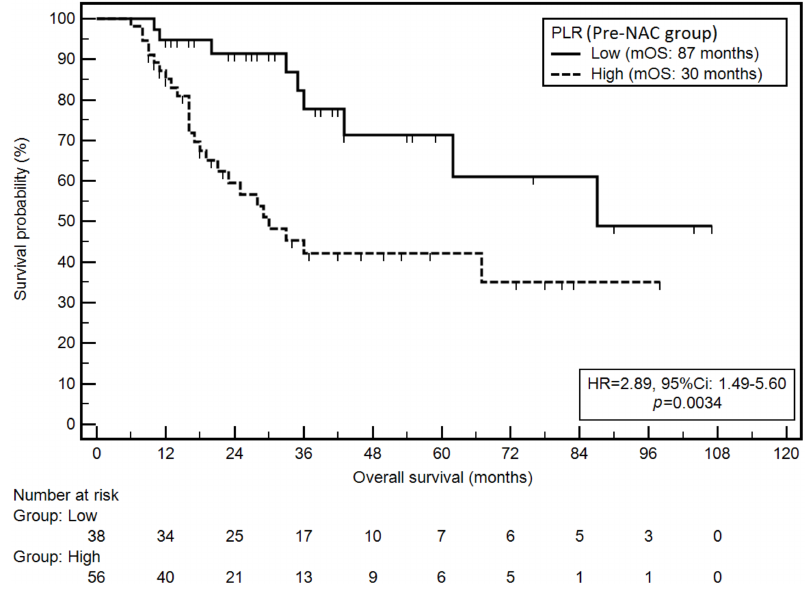
Figure 3. Kaplan–Meier graph representing survival probability in relation to the PLR (pre-NAC